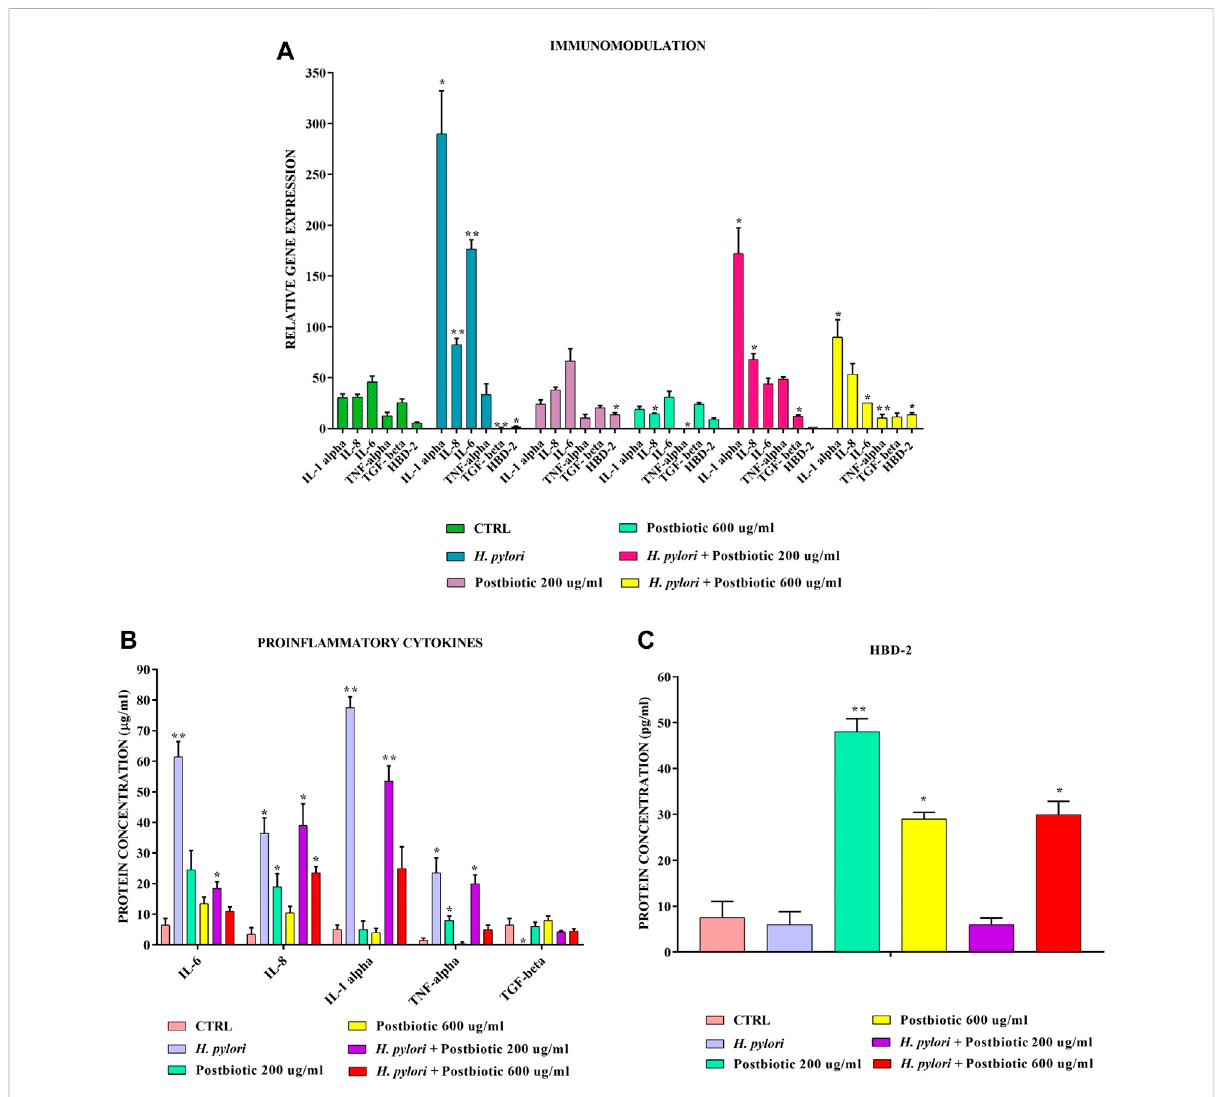
FIGURE 4 Real-TimePCR (A) andELISA (B,C) showtheexpressionlevelsofproin fl ammatorycytokinesandHBD-2inAGScellsinfectedwith H.pylori and/ orpotential postbiotics of L. brevis SP48. Data areexpressedas relativemRNAs expression (A) andproteinconcentration (B,C) in eachgroup and are representative of three different PCR and ELISA experiments ±SD. RNA was extracted from 3 different AGS cell samples treated with the same batch of H. pylori and postbiotics. Signi fi cant differences are indicated by * p < 0.05, ** p < 0.01, and *** p <